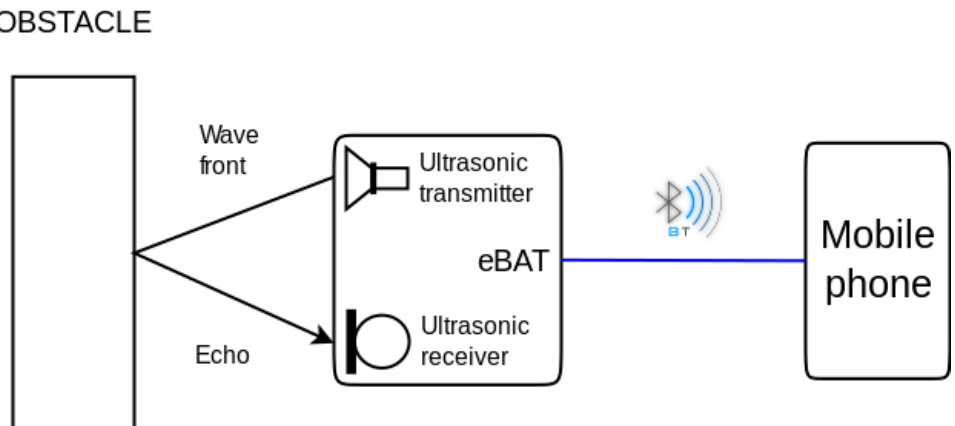
Figure 15. Block diagram of the eBAT working process. The range sensor emits an ultrasonic wave that is reflected by any obstacle in the path and received back as an echo. The eBAT then transmits the measured distance to a mobile phone connected through Bluetooth.